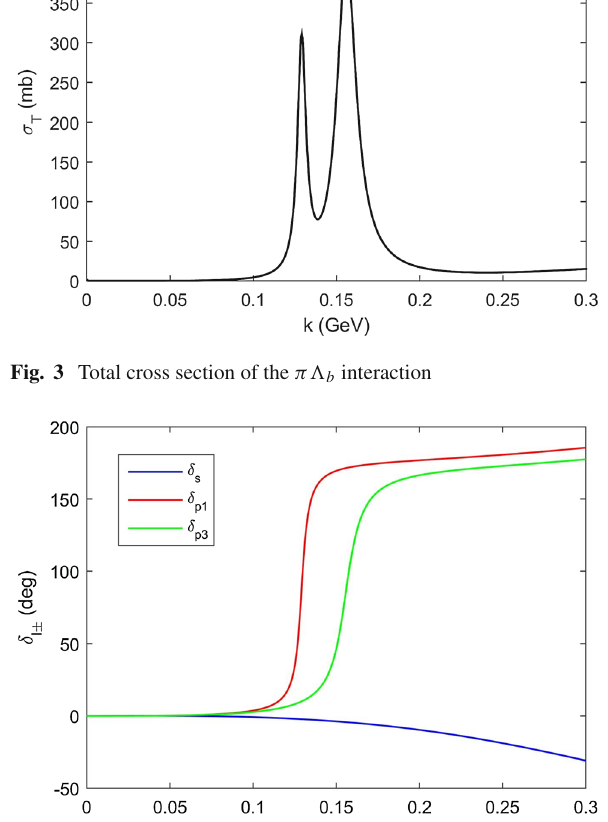
Fig. 2 Breit–Wigner fit for the (cid:14) b and (cid:14) ∗